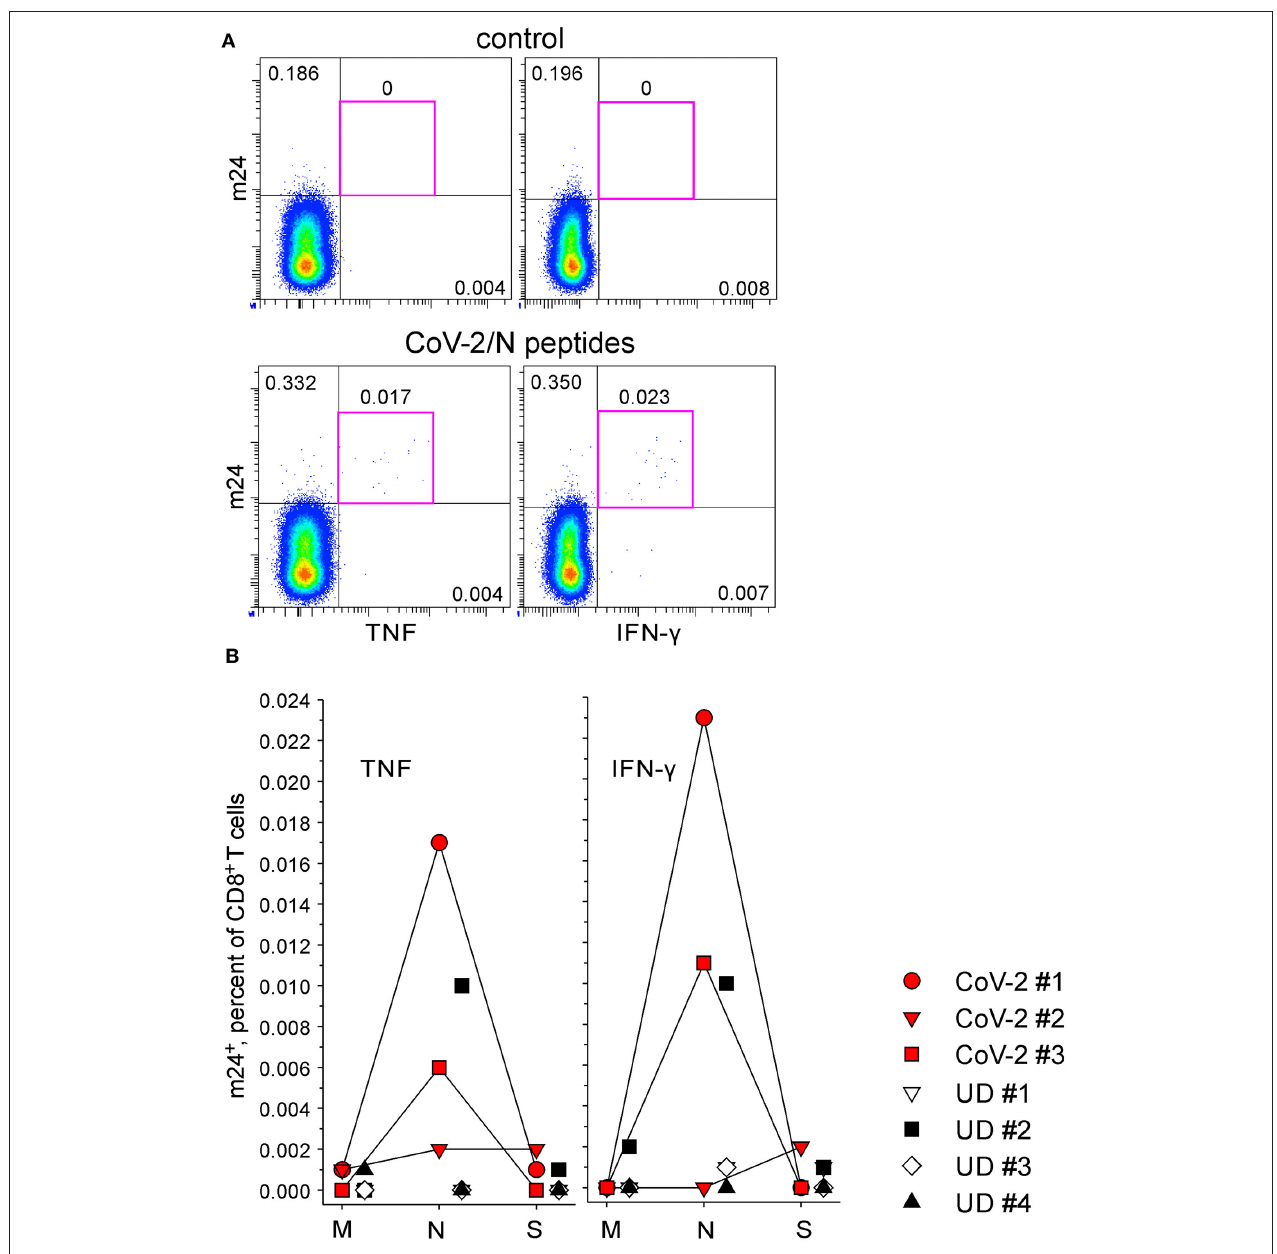
FIGURE 8 | The functional profile of SARS-CoV-2-specific m24 + CD8 + WB T cells. m24 Ab staining in combination with TNF or IFN- γ expression after 4h of stimulation with pools of SARS-CoV-2 M-, N-, and S-derived overlapping peptides. (A) Examples of m24 Ab staining from CoV-2 #1 obtained without stimulation (control, top) or in the presence of N peptides (bottom). Numbers indicate frequencies among CD8 + T cells in %. (B) The results for marker + m24 + CD8 + T cells obtained from SARS-CoV-2 convalescents ( n = 3, CoV-2 #1 to #3) and unexposed healthy donors ( n = 4, UD #1 to #4) are shown as graphs (after subtraction